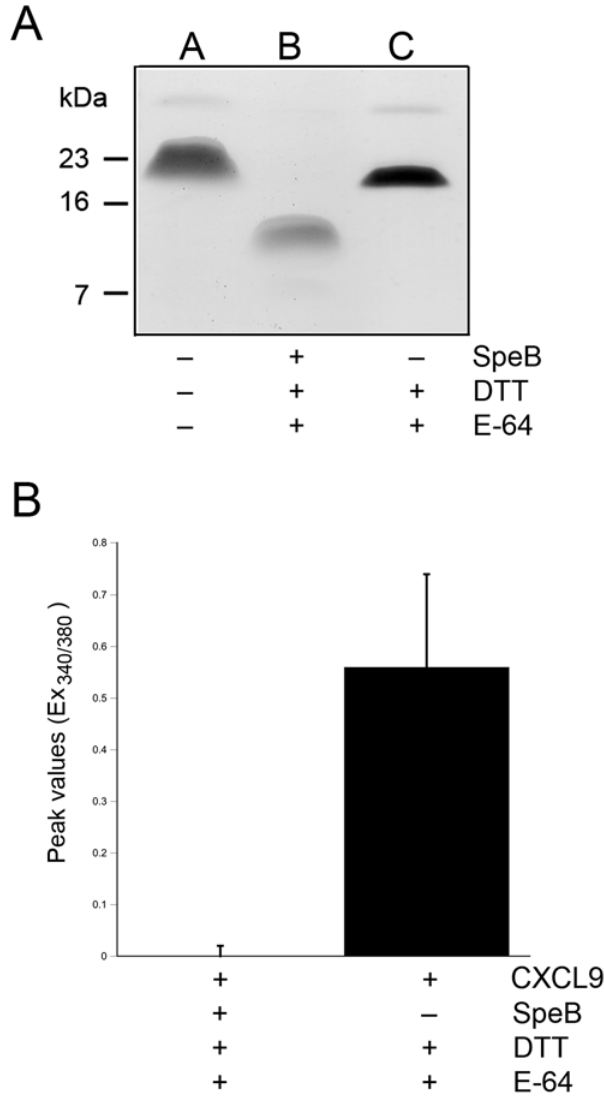
Figure 3. SpeB-hydrolyzed CXCL9 does not signal through CXCR3. Panel A: CXCL9 was incubated with SpeB / DTT or DTT and terminated by addition of the cysteine proteinase inhibitor E-64. Samples were separate on 16.5% SDS-PAGE and compared with intact CXCL9. Panel B: Analysis of calcium flux in Fura-2 loaded CXCR3- expressing pre-B cells upon stimulation with MIG incubated with SpeB / DTT or CXCL9 incubated with DTT alone, both terminated with E-64. Peak values of the Ex340/380 ratio fluorescence curves are presented as means and standard deviations from three independent experiments.